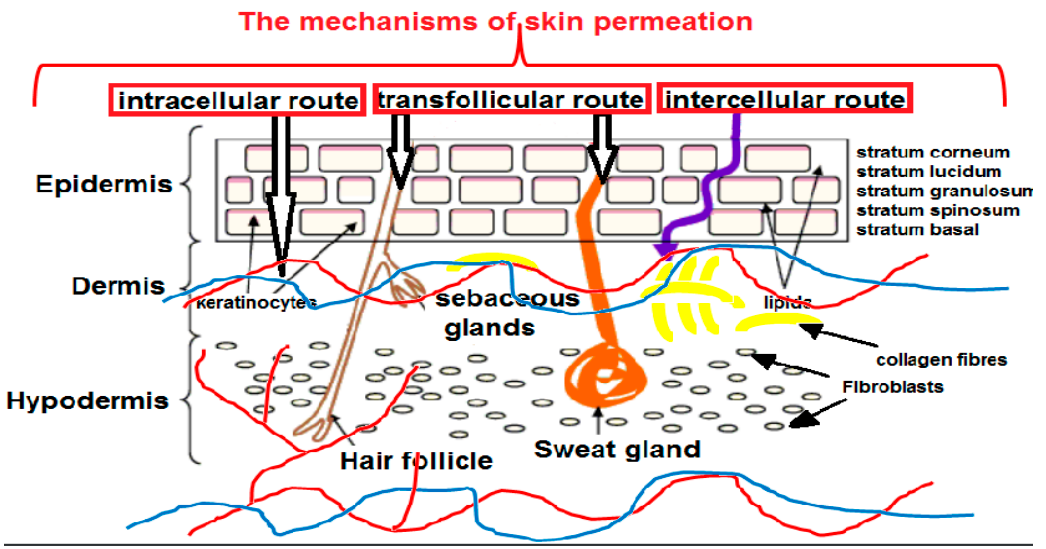
Figure 1. The schematic representation of the possible routes of the NPs permeation through the multilayered structure of the skin together with its main components and blood vessels (artery ‐ red, vein ‐ blue).